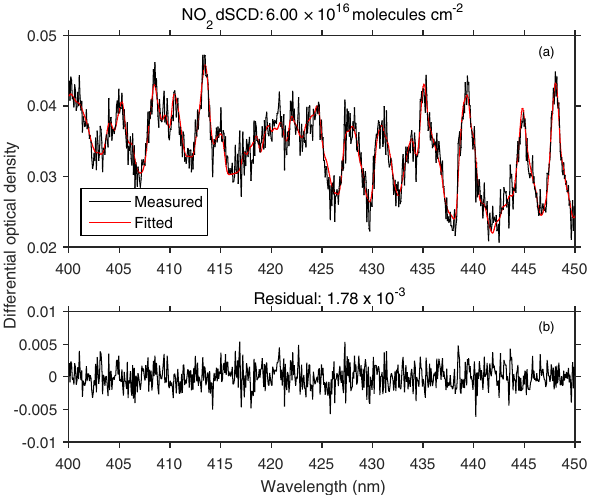
Figure 3. Example of NO 2 fitting results obtained in Guangzhou on 7 April 2015, around 07:50UTC (15:50 local time), at an elevation angle of 15 ◦ and SZA of about 51 ◦ . Panel (a) shows the measured (black) and the fitted (red) NO 2 and (b) shows the residual of the DOAS fit.